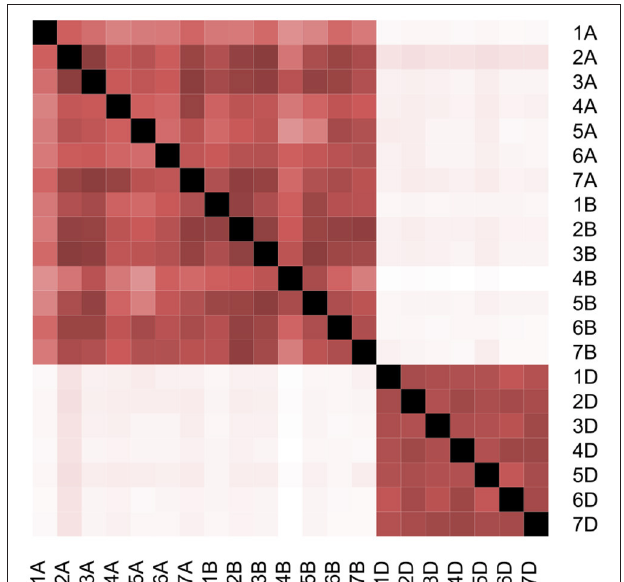
FIGURE 2 | Pairwise correlation between all 21 GRMs for wheat chromosomes. White color represents Pearson coefficient = 0, while black color represents Pearson coefficient =